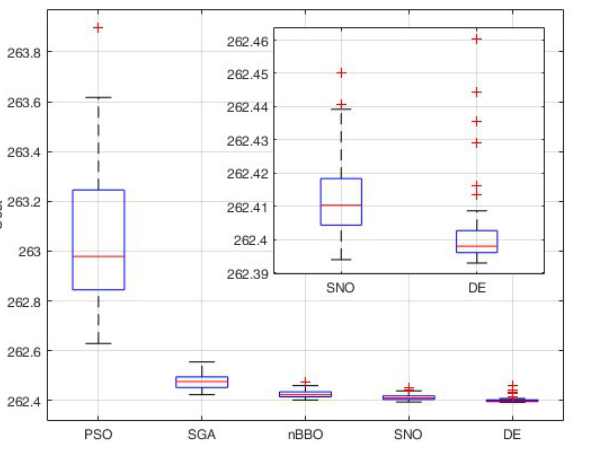
Figure 10. Boxplot of the comparison between the results obtained by several evolutionary algorithms. The direct comparison between SNO and DE shows that this algorithm is much more